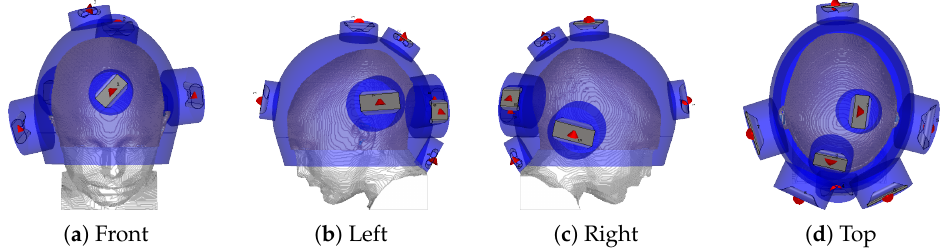
Figure 2. Helmet applicator optimized for the thermal treatment of the tumour considered in this study. The red cones indicate the feed point and polarization direction of each antenna. The blue shade indicates